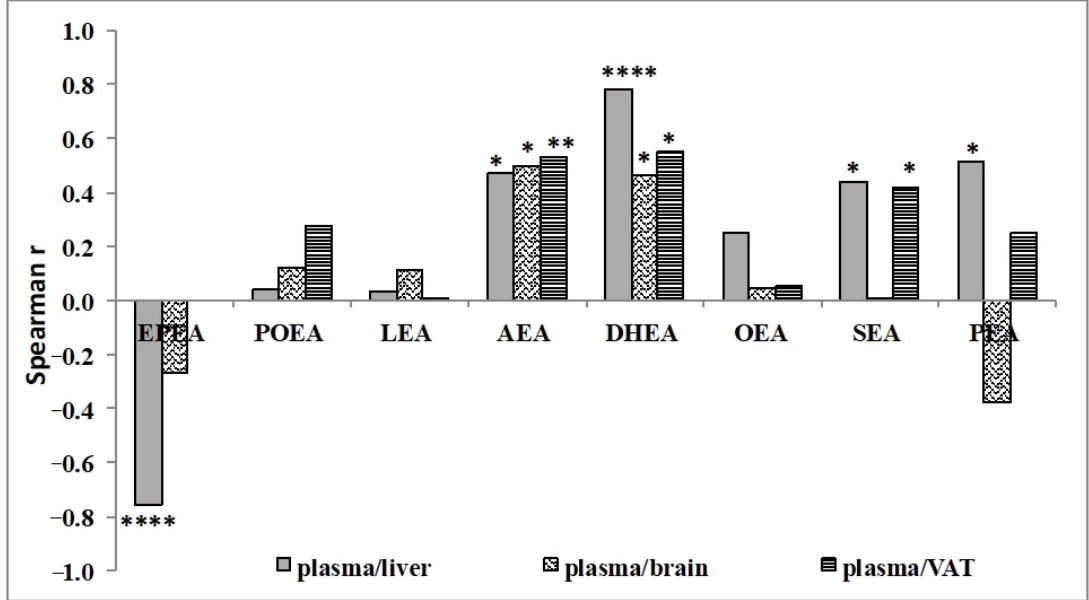
Figure 2. Correlation between levels of NAE species in liver, adipose tissue and brain versus those in plasma in Wistar rats fed with different diets. The correlations studies were determined by Spearman correlation